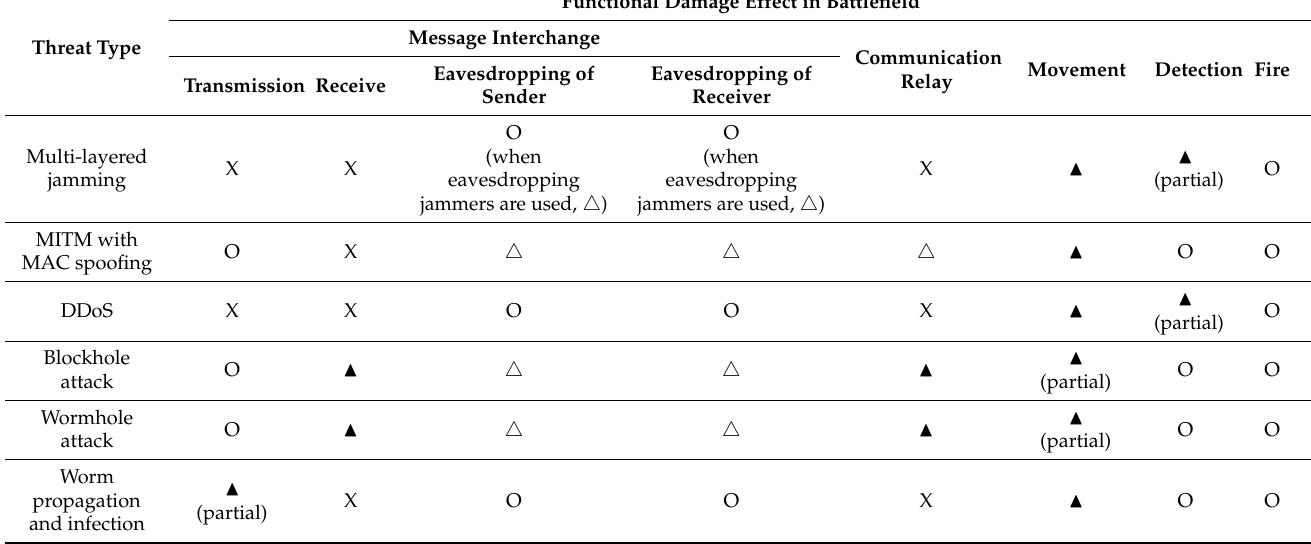
Table 5. Damage effect elements about targeted swarming drone system by cyber-electronic warfare threat in